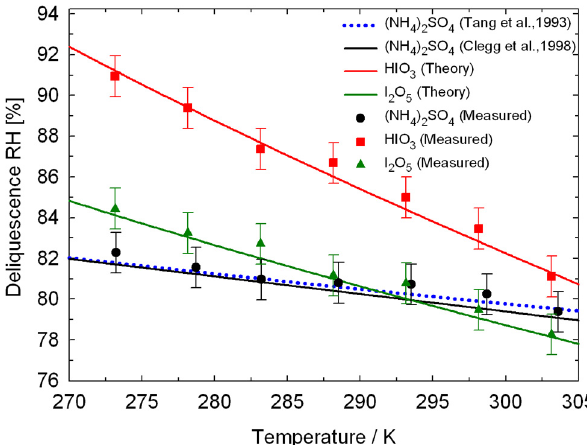
Fig. 9. Measured DRH for (NH 4 ) 2 SO 4 , I 2 O 5 , and HIO 3 crystals as a function of temperature, and their corresponding theoretical fits calculated using equation 7 (see section 3.4). Estimated errors in the measured data are ± 1%